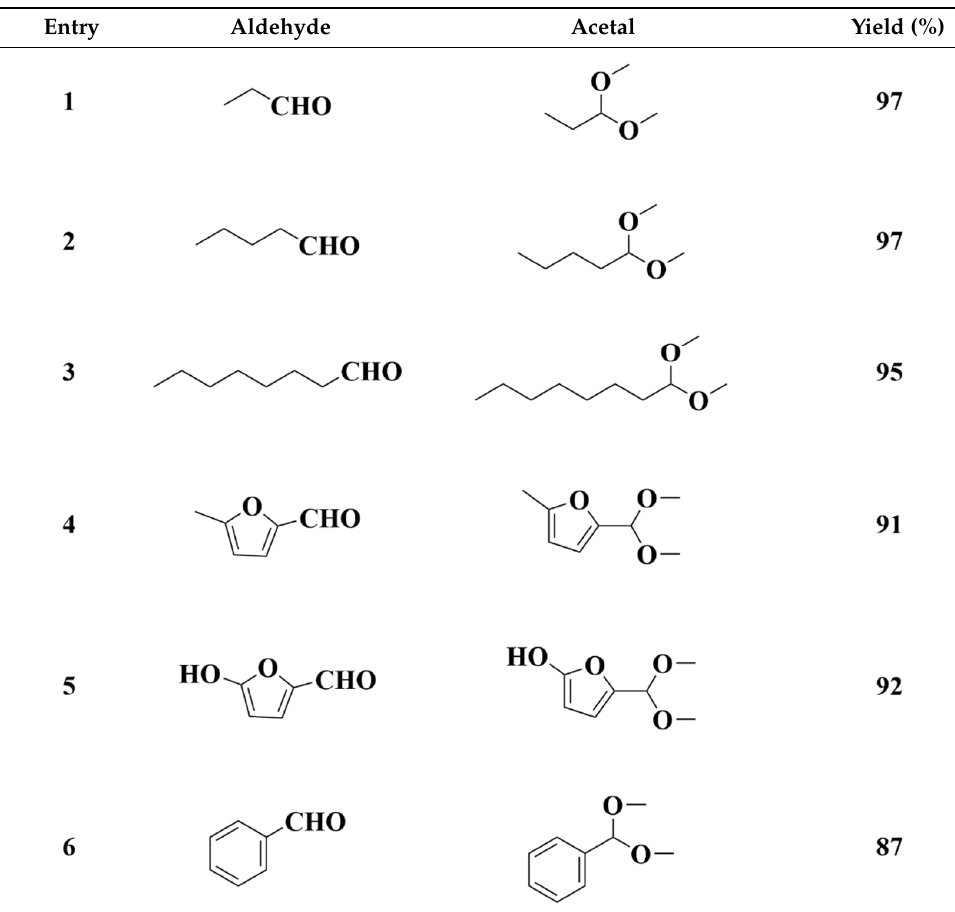
Table 3. Acetalization of various aldehydes was catalyzed by MCS with methanol a .